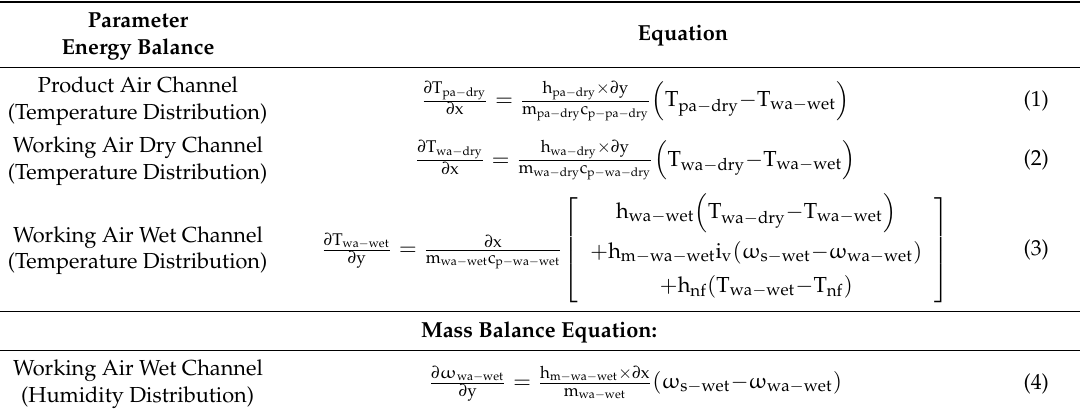
Table 1. Energy and mass balance laws applied to different channels of the heat and mass exchanger